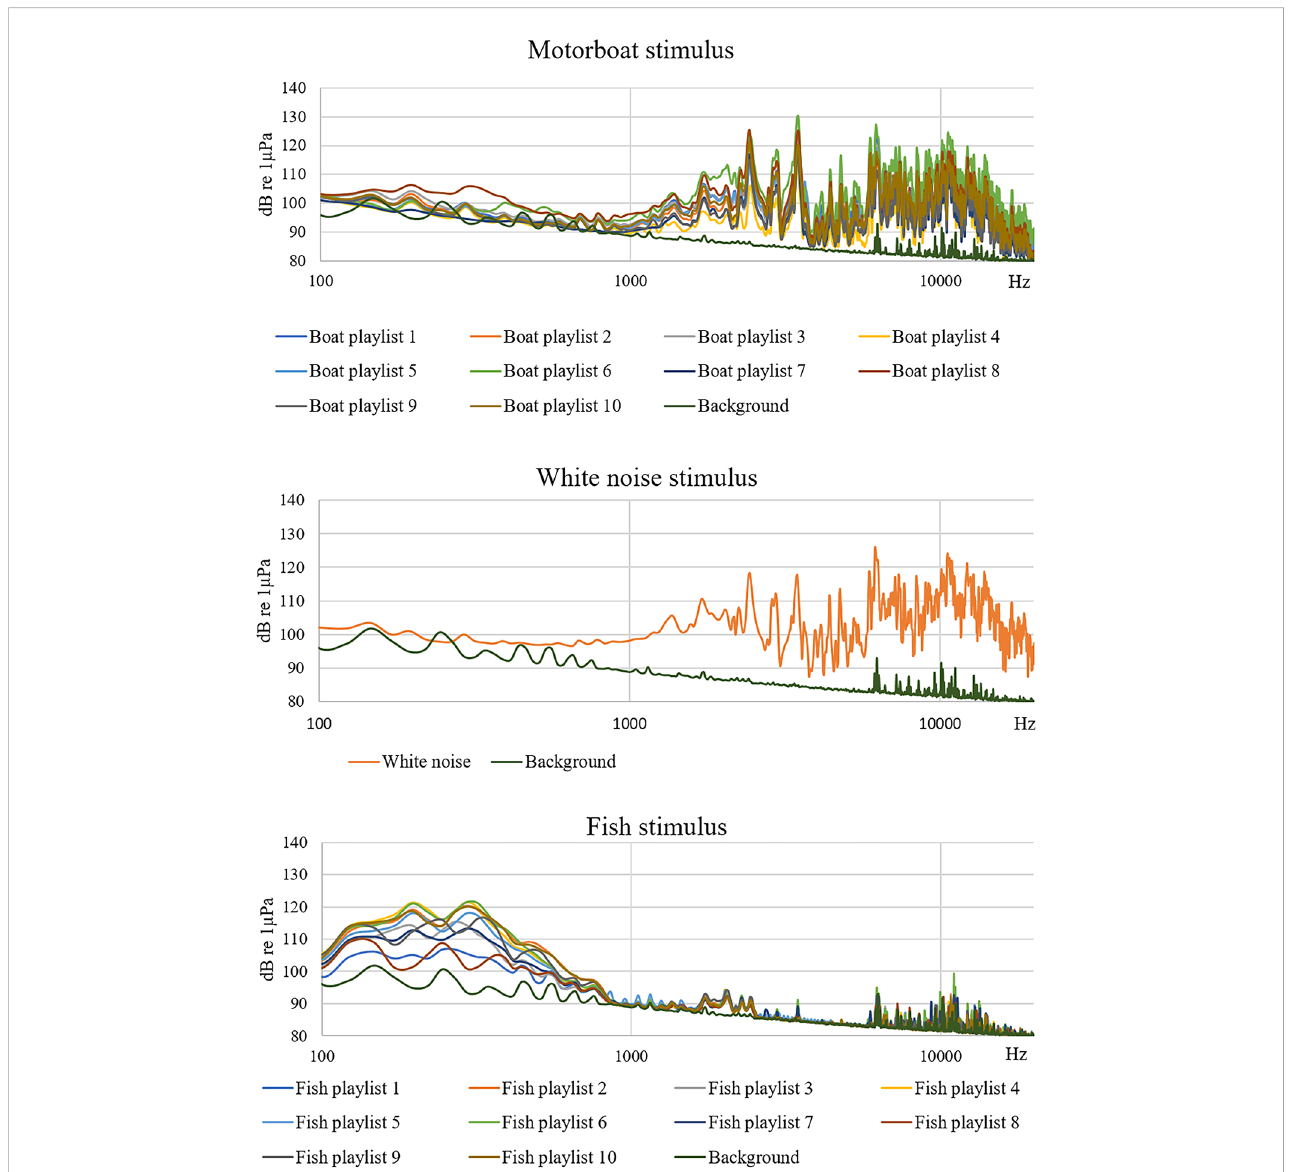
FIGURE 2 Power spectrum of all playlists with a high rate emission pattern of the motorboat, white noise and fi sh stimuli (FFT size 4096, hamming window, resolution 24.4